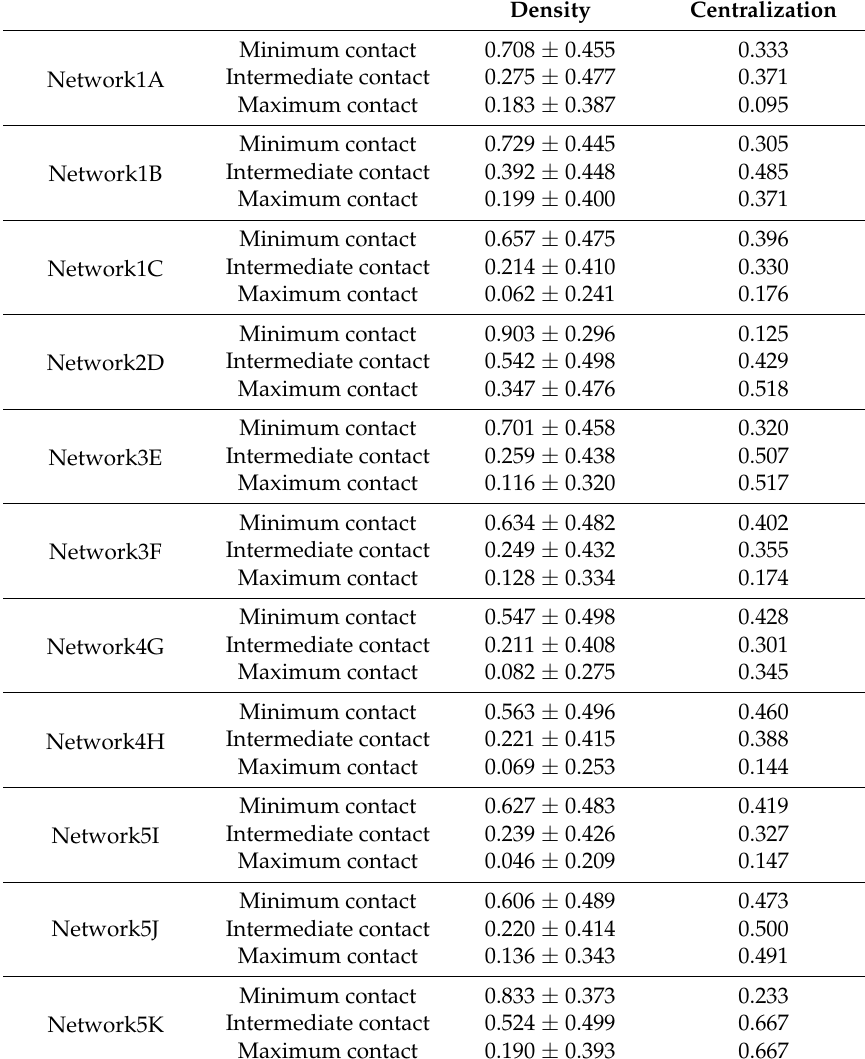
Table 3. Density and centralization for each of the studied